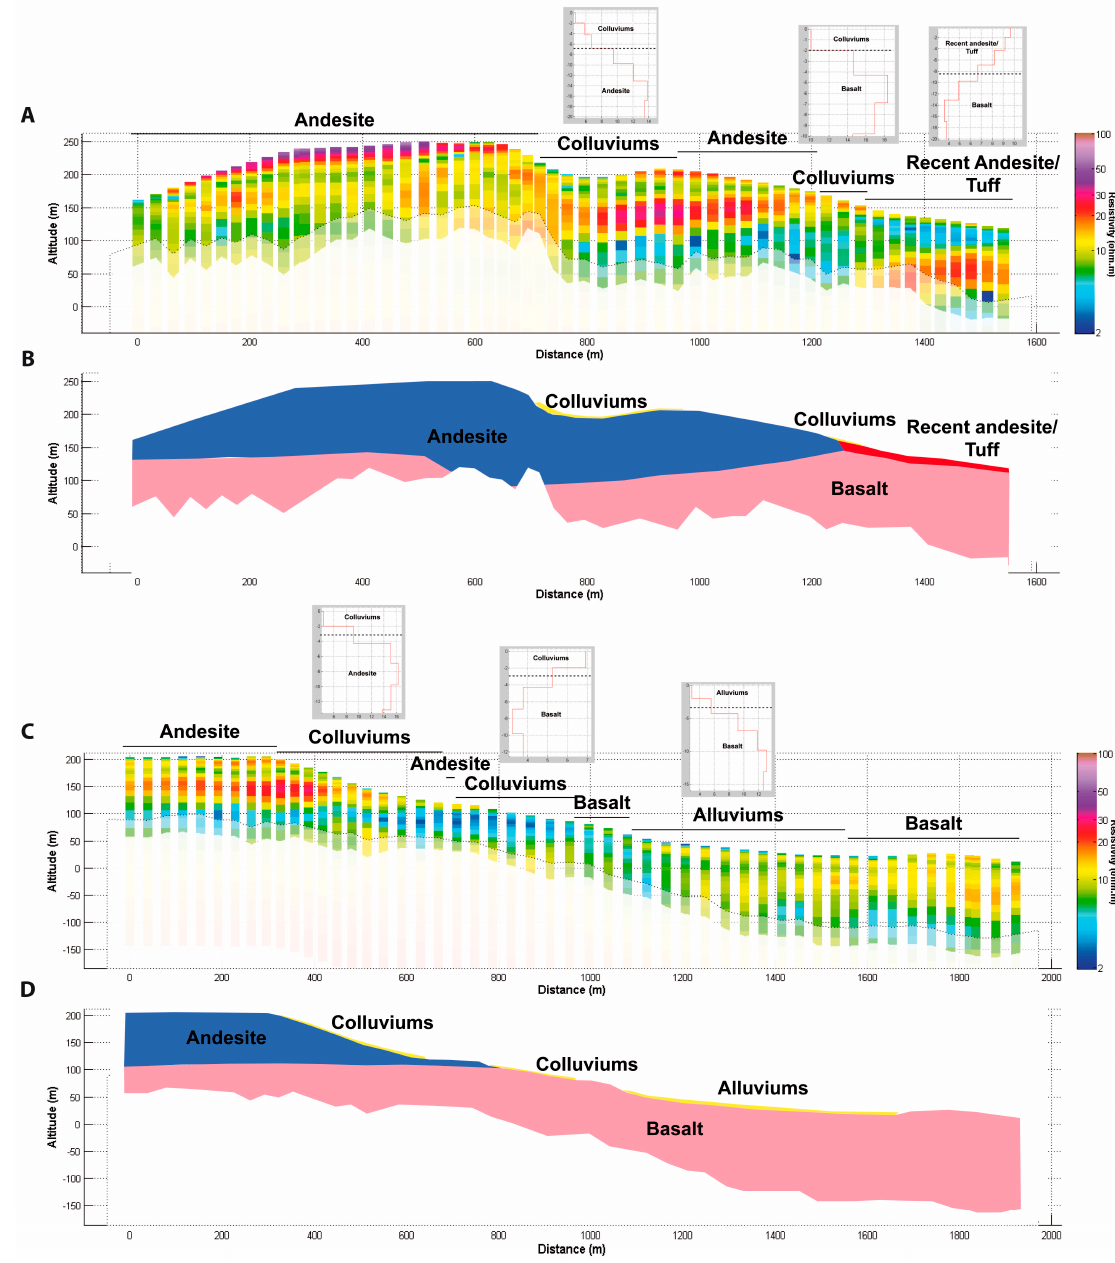
Figure 6. Resistivity results and interpretations. ( A ) Resistivity profile n°1; ( B ) resistivity profile n°1 interpretation; ( C ) resistivity profile n°2; ( D ) resistivity profile n°2 interpretation.